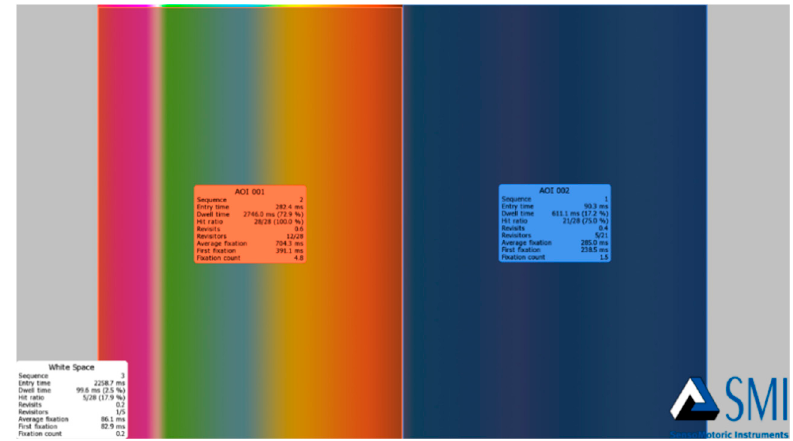
Figure 5. Key Performance Indication (executive summary). The AOI of the color scale after a positive emotional stimulus.